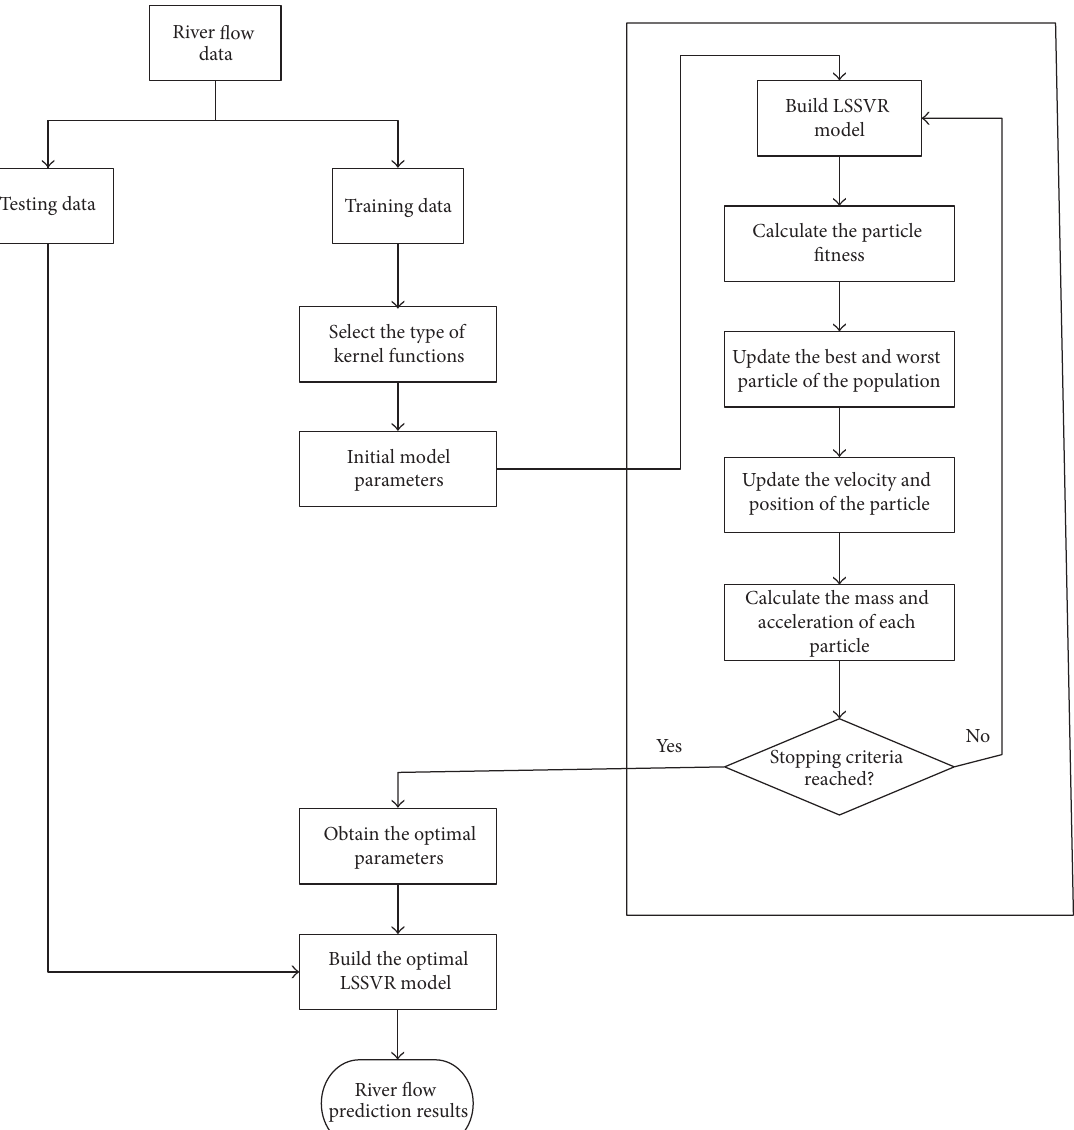
Figure 2: Flow chart of HLGSA model for river flow